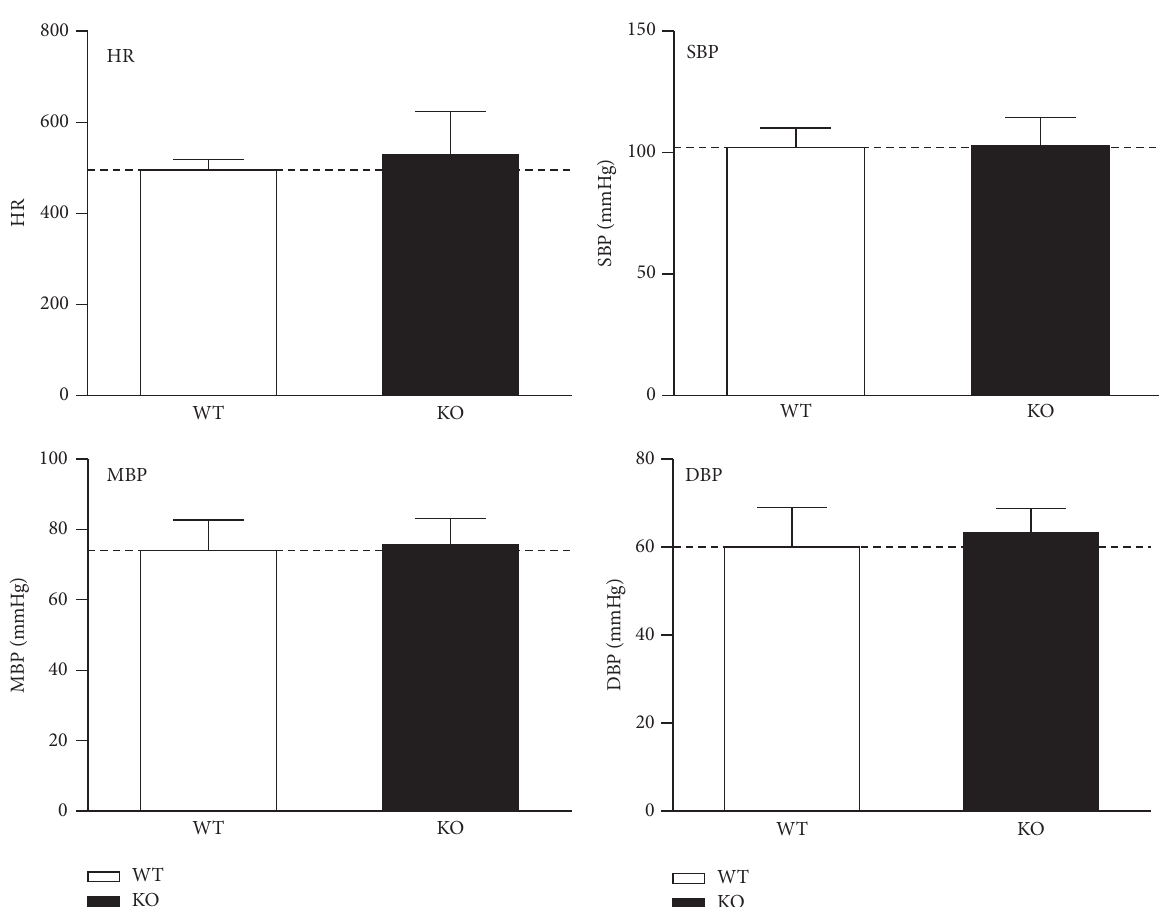
Figure 7: Figure 7 showed phenotypic analysis of KO mice; there was no significant difference in systolic blood pressure (SBP), diastolic blood pressure (DBP), mean blood pressure (MBP), and the heart rate at baseline. Glucose and blood routine examination showed no significant difference at